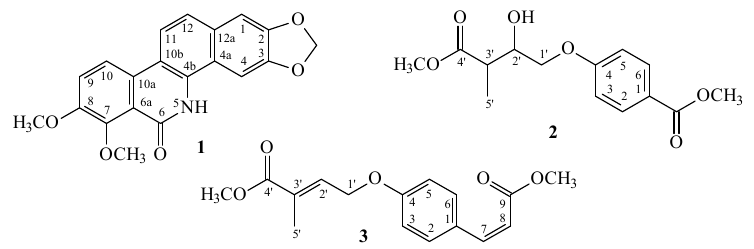
Figure 1. The chemical structures of new compounds 1 – 3 isolated from Zanthoxylum ailanthoides